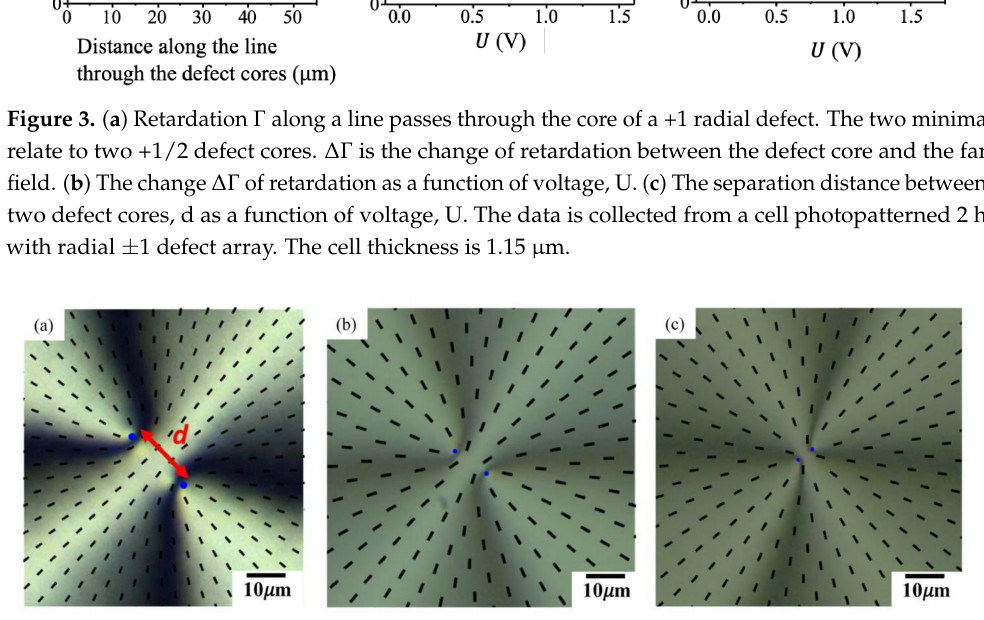
Figure 4. Optical microscopy of separation of + 1 radial defects into pairs of + 1/2 defects for irradiation times of ( a ) 2 min, ( b ) 10 min, and ( c ) 30 min. Cell thicknesses are 1.2 µ